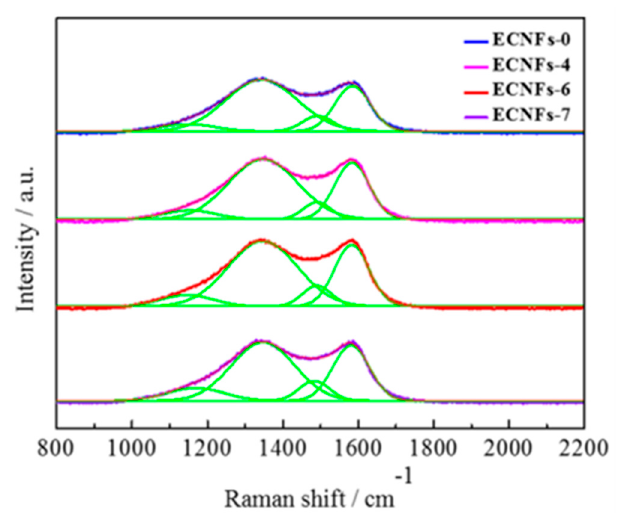
Figure 4. Raman spectra of ECNFs.